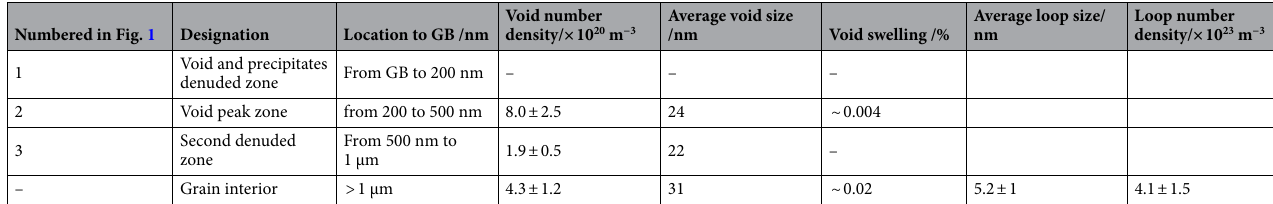
Table 3. Quantitative and statistical data of voids obtained near the GBs separately for different zones.